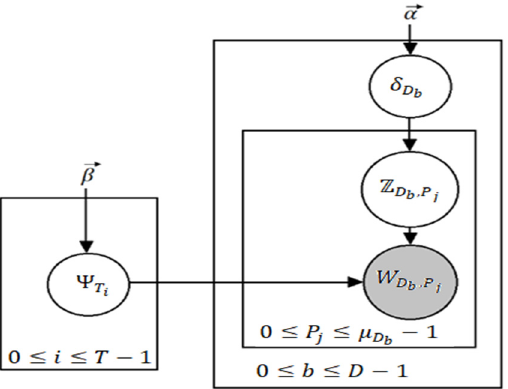
Figure 4. Plate notation for LDA where grey signifies an entity that can be